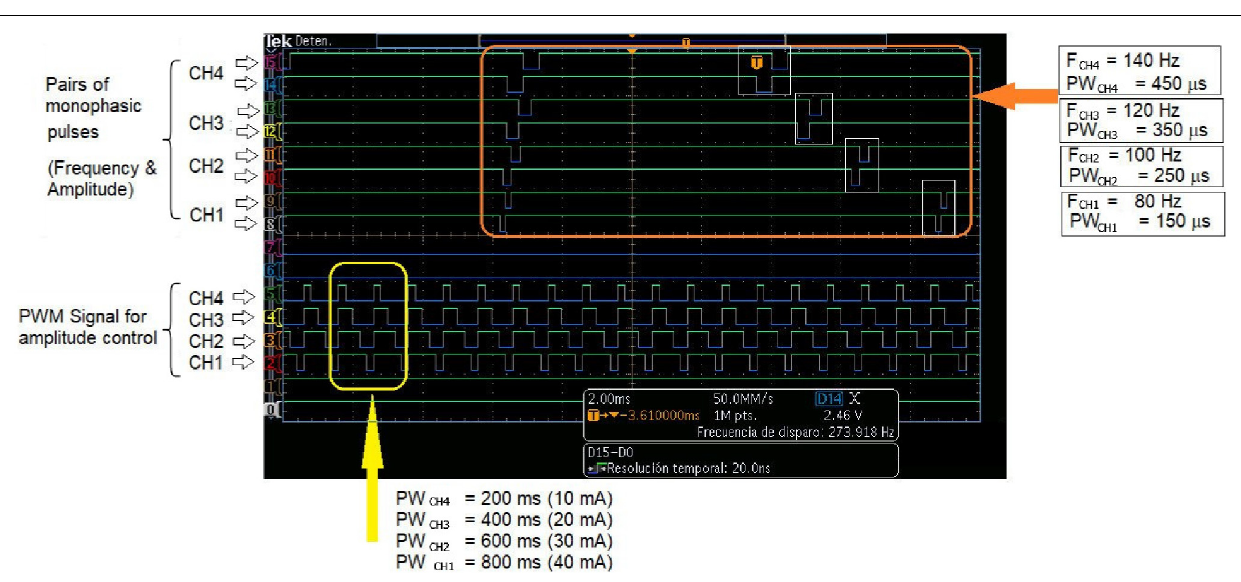
FIGURE 6 | Multichannel operation of the PG-nFEs. Top: Pairs of monophasic pulses corresponding to four stimulation channels. The small white rectangles inside the big orange rectangle highlight the phase delay between each pair of pulses, required for forming the biphasic stimulation pulses in the output stage. Each channel was programmed with different frequency and pulse width settings, shown at the right of the oscilloscope’s screenshot. Bottom: PWM signals for amplitude control of the four stimulation channels. The yellow rectangle in the left highlights the difference in duty cycle of the signals. The bottom text indicates the nominal value of the pulse width and amplitude for each channel and the corresponding settings of stimulation